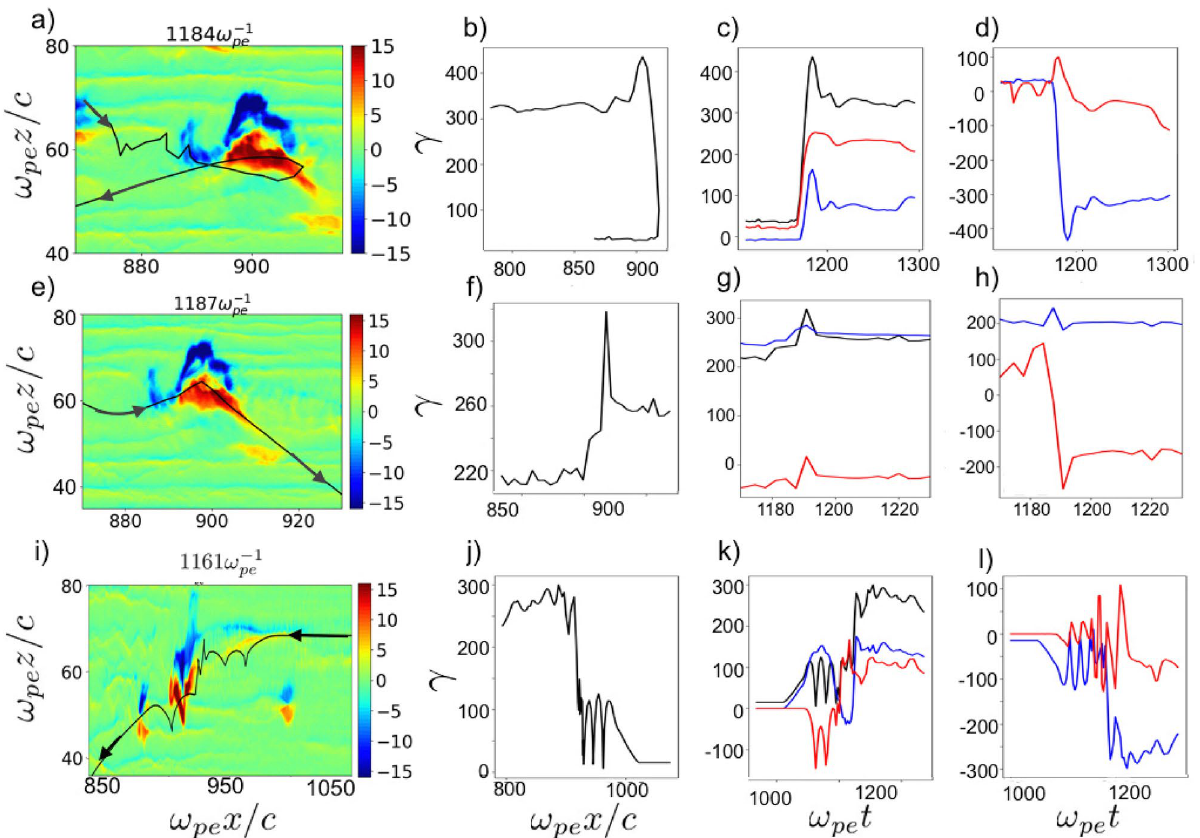
Figure 6. Left column ( a , e , i ) shows the distributions of transverse electric fields of MV. The trajectories of energized electrons are superimposed and shown by black color. The middle column ( b , f , j ) shows the electron energy as a function of x . The third column ( c , g , k ) illustrates electron energies (black) and work done by longitudinal (blue) and transverse (red) electric fields on the particle as a function of time. The fourth column ( d , h , i ) shows the longitudinal (blue) and transverse (red) momentum ( p x / mc , p z / mc ) of electrons as a function of